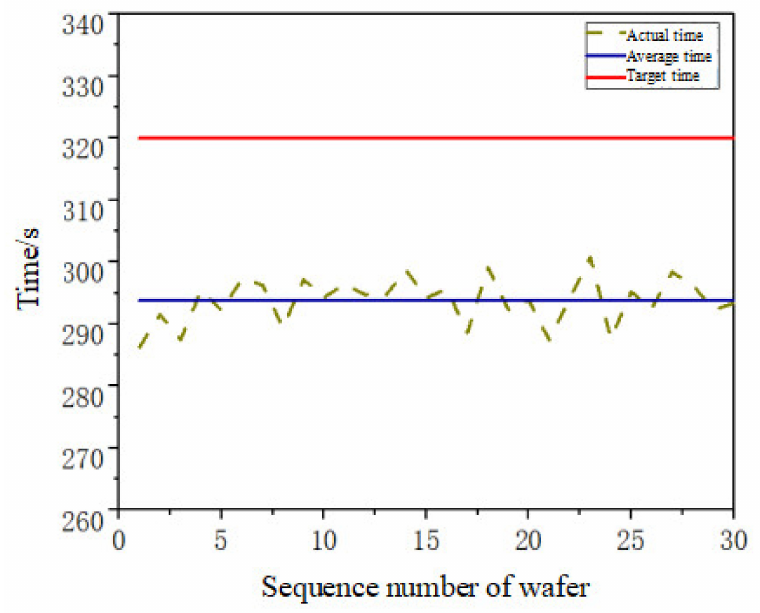
Figure 15. Frequency modulation processing time per row under optimized parameters. The over-frequency rate of each wafer after frequency modulation is recorded and shown in Figure 16. The average defect rate is about 1.401%, which is lower than the over-frequency rate index of 1.56%, meeting the over-frequency rate requirements. The amount of fault alarms of laser processing systems for MCR frequency modulation is recorded every week, and the statistical results are listed in Table 14. The fault alarm rate τ is 0.2 times per week, meeting the reliability